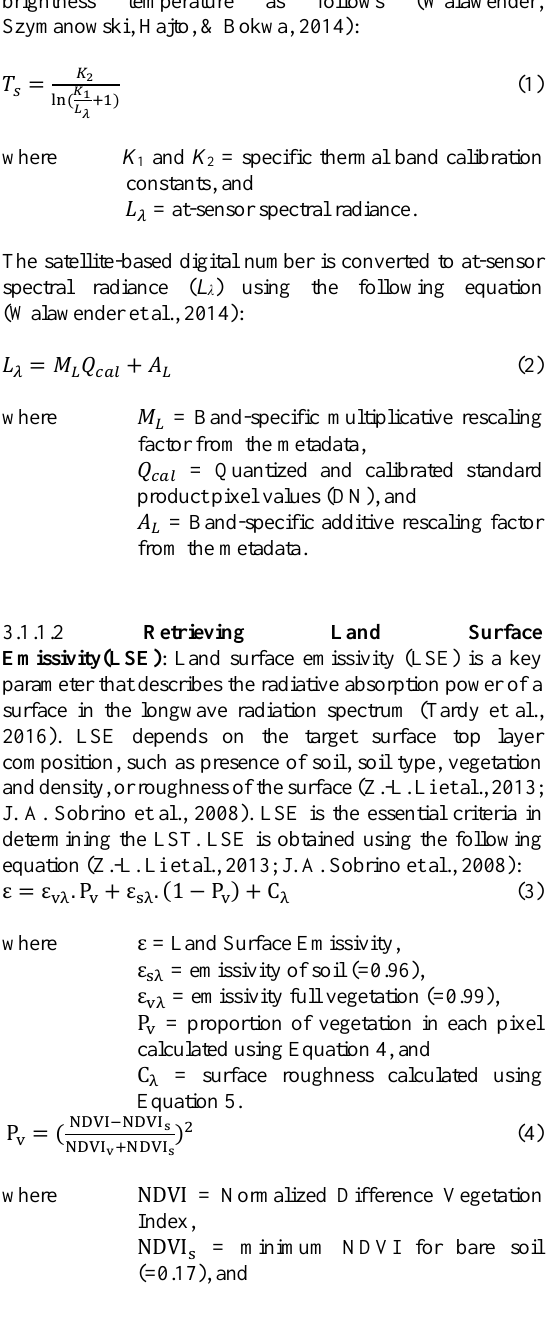
Algorithm) : Single-channel algorithms to calculate the LST are the algorithms that estimate the LST using only one thermal band. Equation 6 explains the general trend algorithm used in this article and Equations 6-11 express